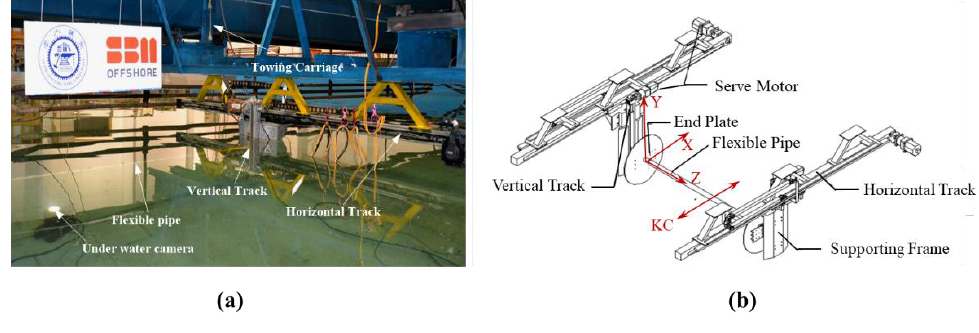
Figure 1. Overview and sketch of the whole experimental setup: (( a ). the overview photo; ( b ). the schematic drawing).